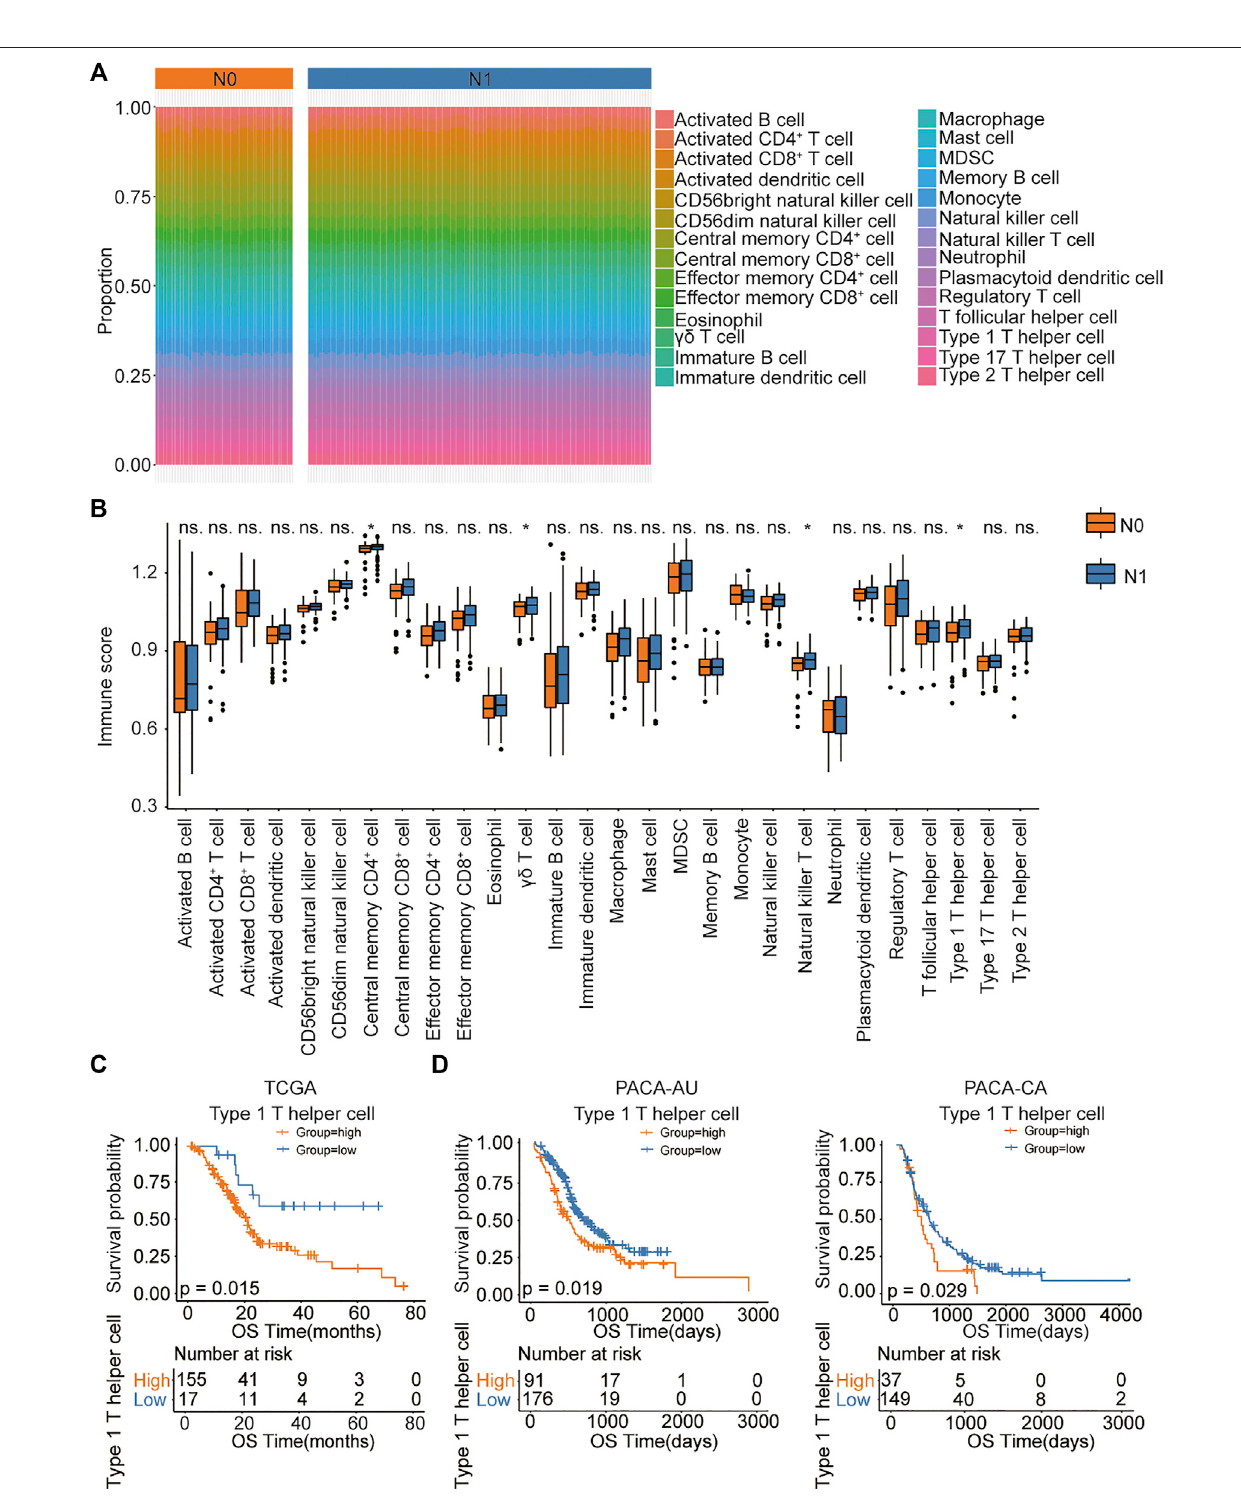
FIGURE 2 | The association between immune cell abundance and lymph node metastatic status in PDAC patients. (A) ssGSEA analysis showing immune in fi ltration of 28 immune cells in TCGA pancreatic cancer samples. (B) The proportion of immune cell in fi ltration in lymph node metastatic and nonmetastatic samples. (C,D) Kaplan – Meier curves for the OS of PDAC patients showing that the patients with high type 1 T helper cell abundance had a poor outcome compared with the patients with low type 1 T helper cell abundance in the TCGA, PACA-AU, and PACA-CA cohorts. Abbreviations: CD, clusters of differentiation; MDSC, myeloid-derived suppressor cells; N0, indicate patients without lymph node metastasis; N1, indicate patients with lymph node metastasis; ns, no signi fi cant; OS, overall survival; PDAC, pancreatic ductal adenocarcinoma; ssGSEA, single-sample Gene Set Enrichment Analysis; TCGA, The Cancer Genome Atlas.